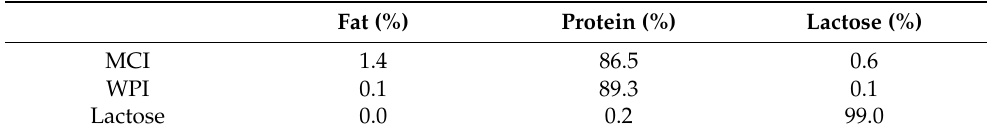
Table 1. Powder specifications of micellar casein isolate (MCI), whey protein isolate (WPI) and lactose ( w / w ).